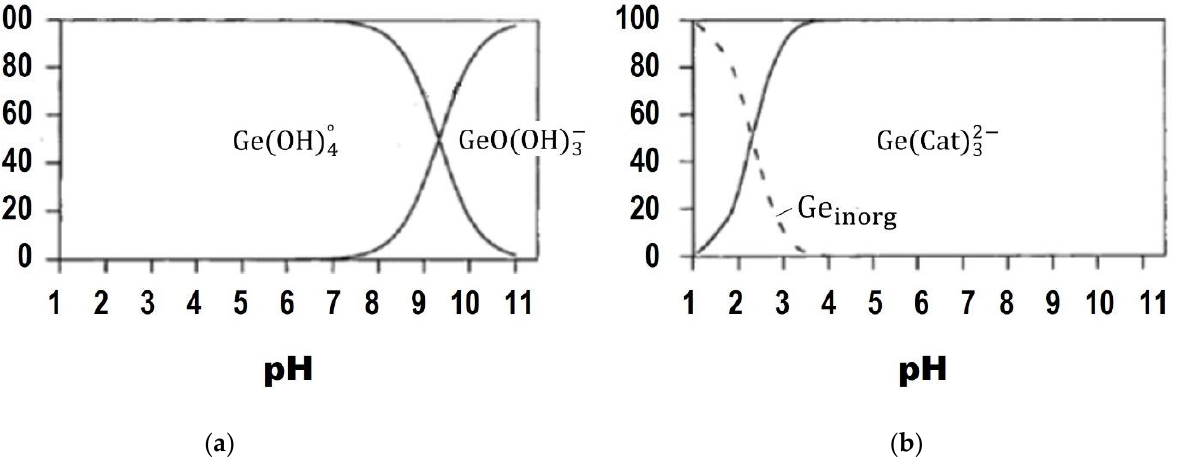
Figure 3. Distribution curves of hydroxide complexes of Ge ( a ) and complexes of Ge and catechol ( b ) as a function of pH at 25 ◦ C in aqueous solutions containing 0.02 M of Ge and 0.1 M of catechol. Reprinted with permission from ref. [21].